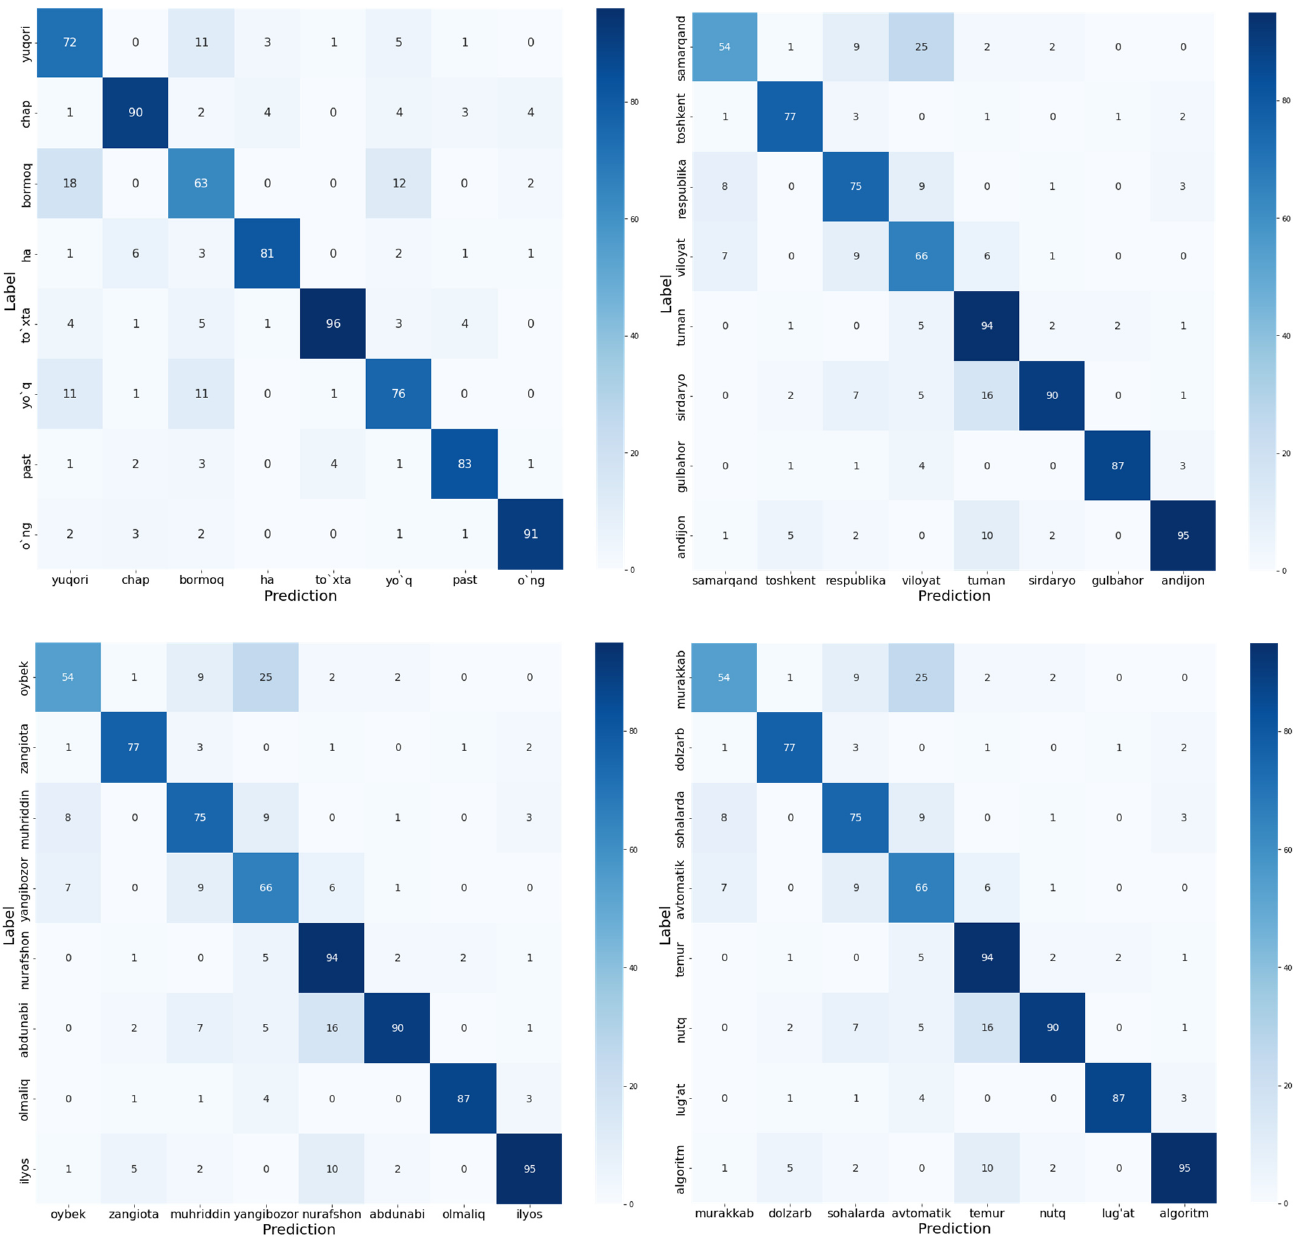
Figure 10. Confusion matrix of actual labels and the prediction of the proposed E2E − T model. The rows represent an actual label and columns represent corresponding prediction results.